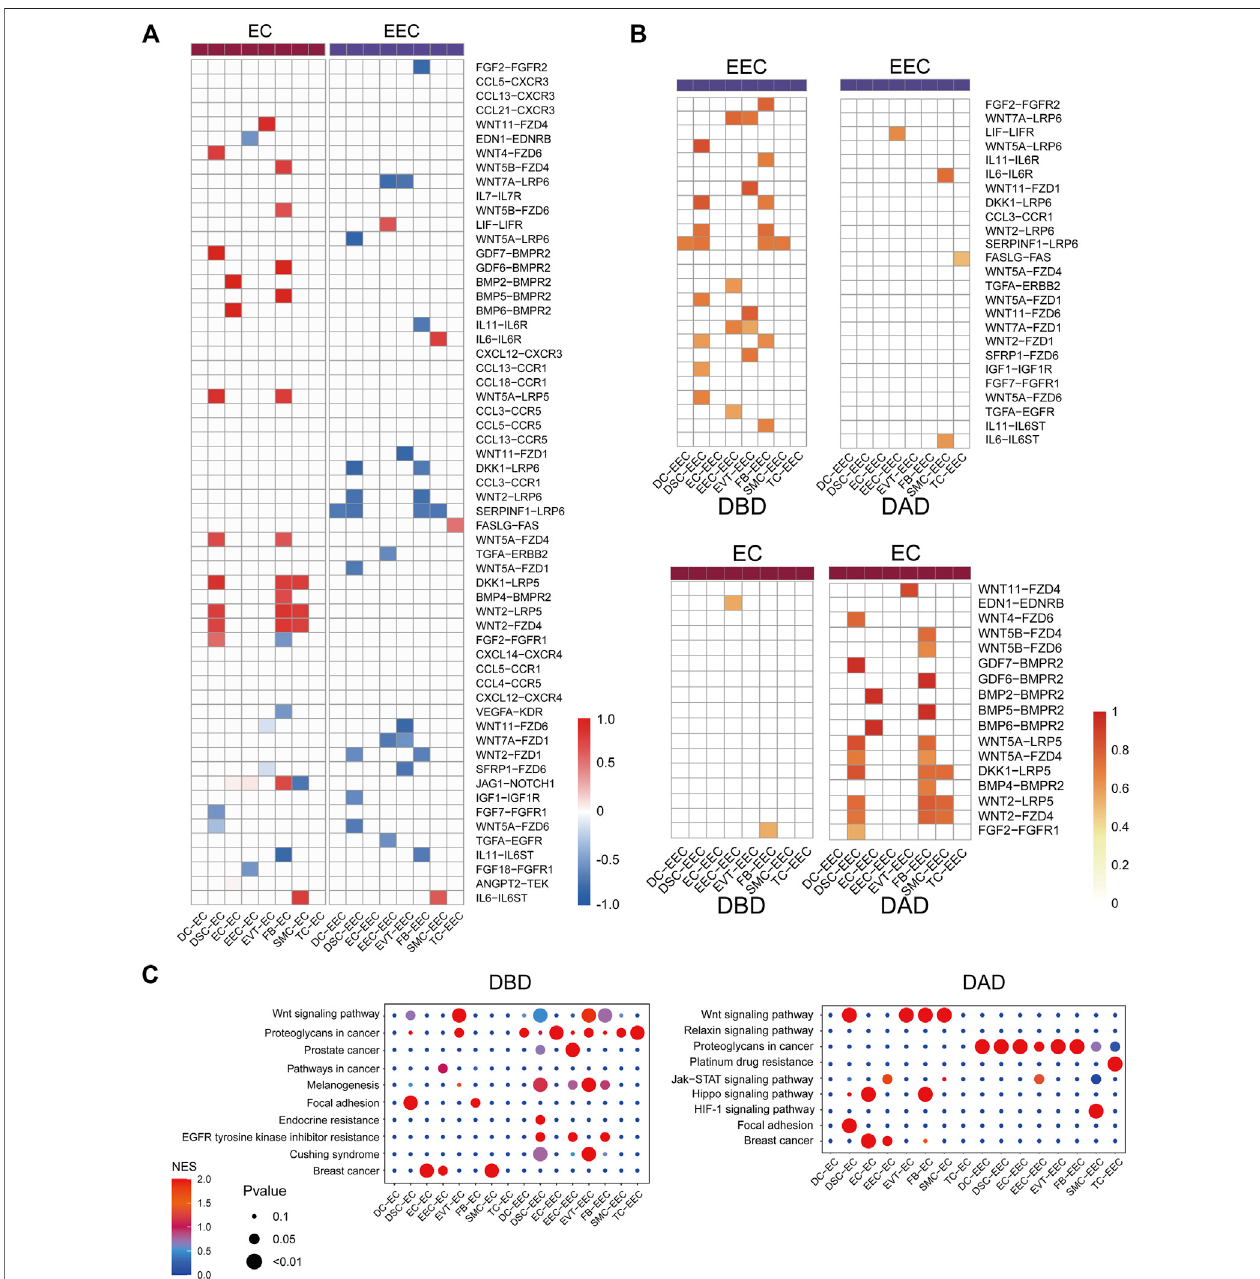
FIGURE3| DifferentialintercellularcommunicationbetweenDADandDBD. (A) HeatmapofdifferentialintercellularsignalsrelatedtoECsandEECs;redrepresents signi fi cantly increased intercellular communication in DAD; blue represents signi fi cantly decreased intercellular communication in DAD. (B) Details of differential intercellular communication related to ECs and EECs; red represents the score of intercellular communication. (C) Pathway activity analysis of differential intercellular communication related to ECs and EECs.